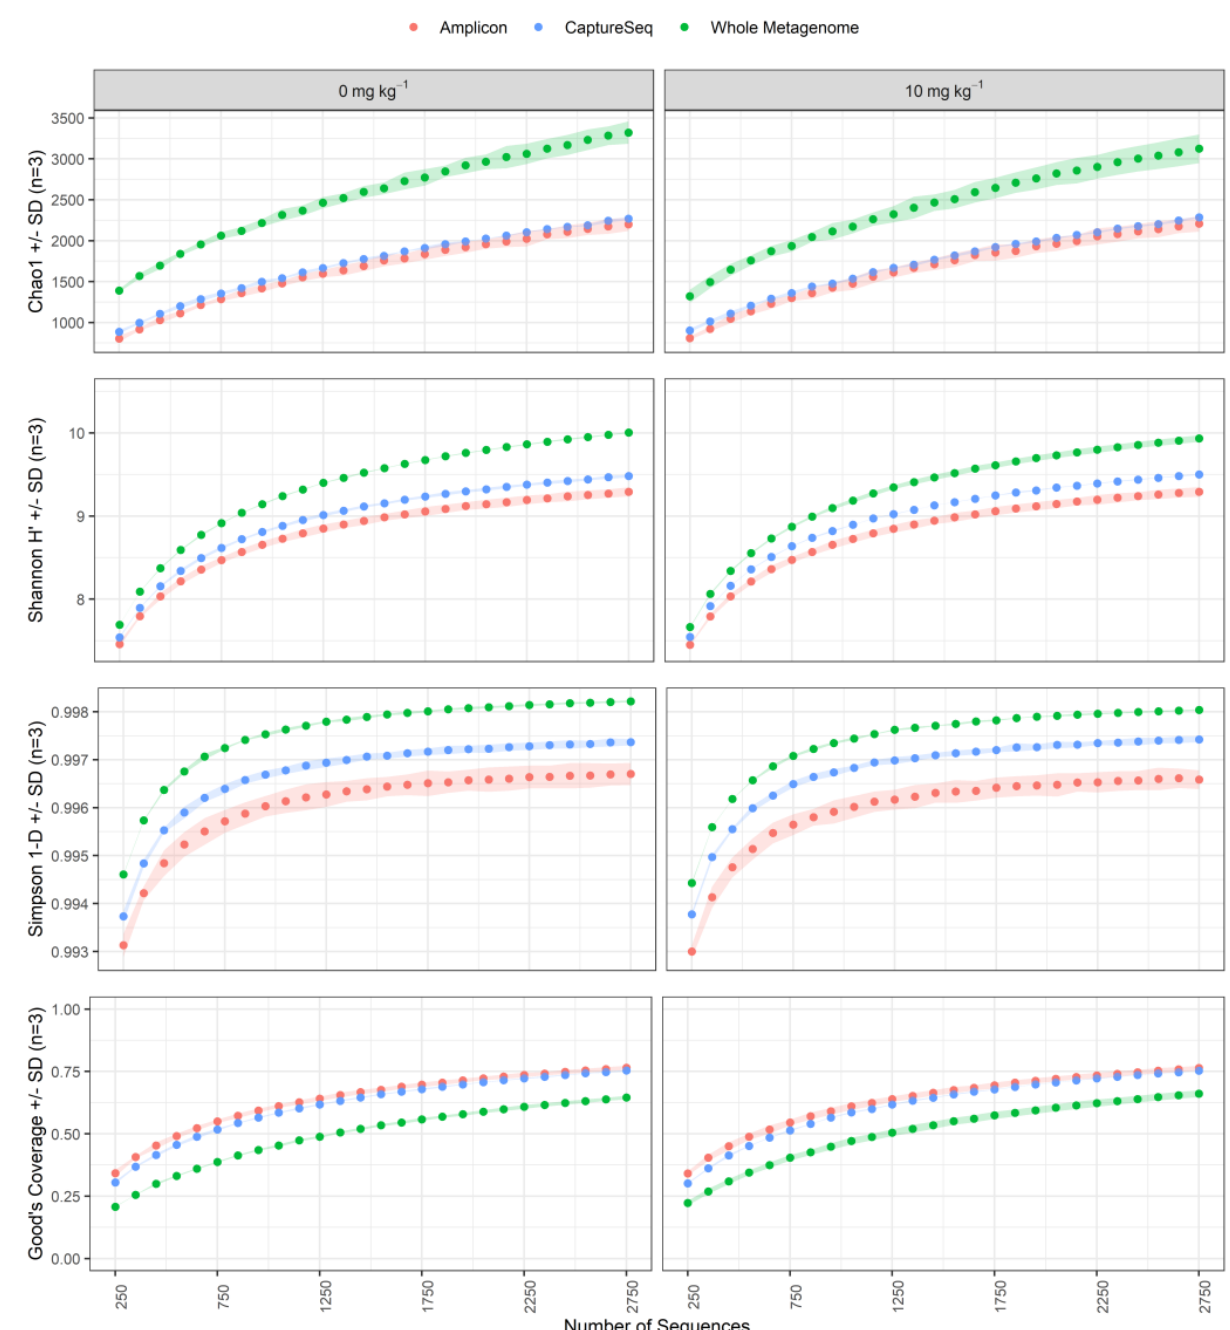
Figure 5. Alpha diversity metrics for soil samples profiled using cpn60 amplicon (red), CaptureSeq (blue), or shotgun metagenomic (green) approaches. Metrics were calculated using libraries that were down-sampled from 250–2750 reads and were averaged across 100 bootstrapped datasets. The shaded area corresponds to the standard deviation of the three replicate soil plots for each antibiotic treatment condition.